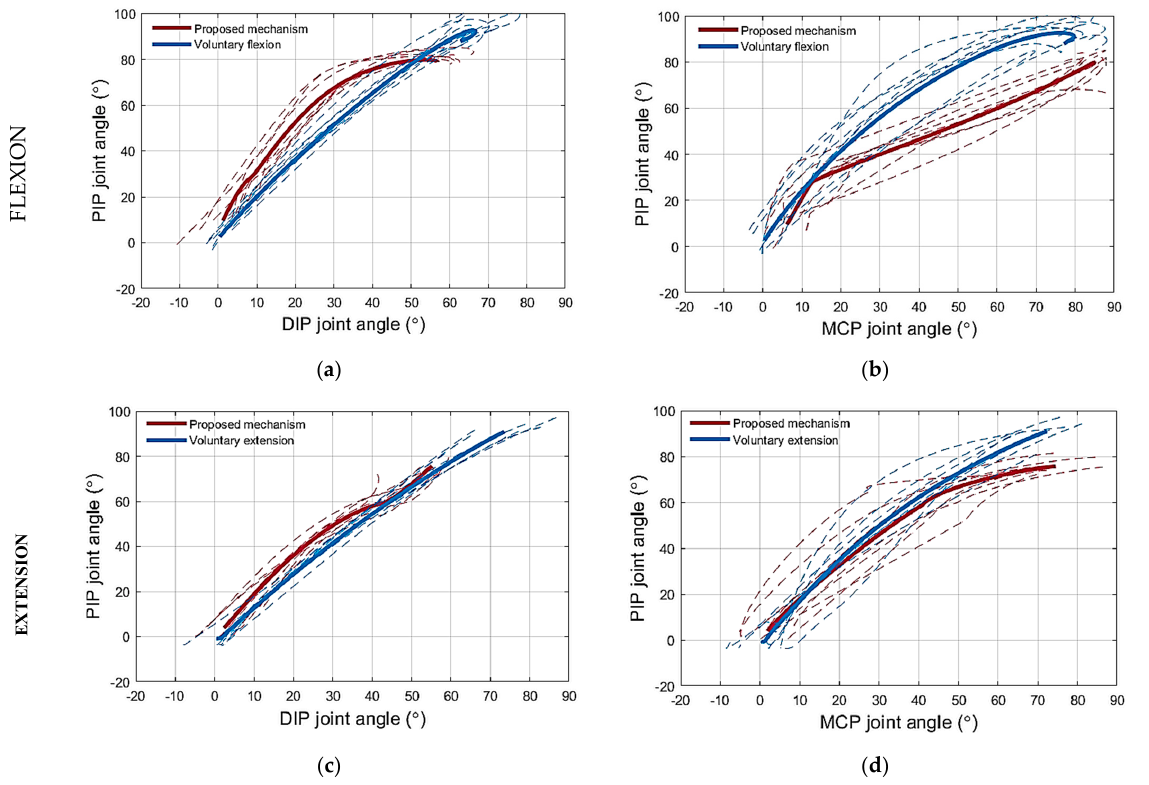
Figure 10. The phase plots for the finger joint angles during flexion and extension for the middle finger of healthy subjects using the novel mechanism: ( a ) PIP–DIP joint angle relation during flexion;